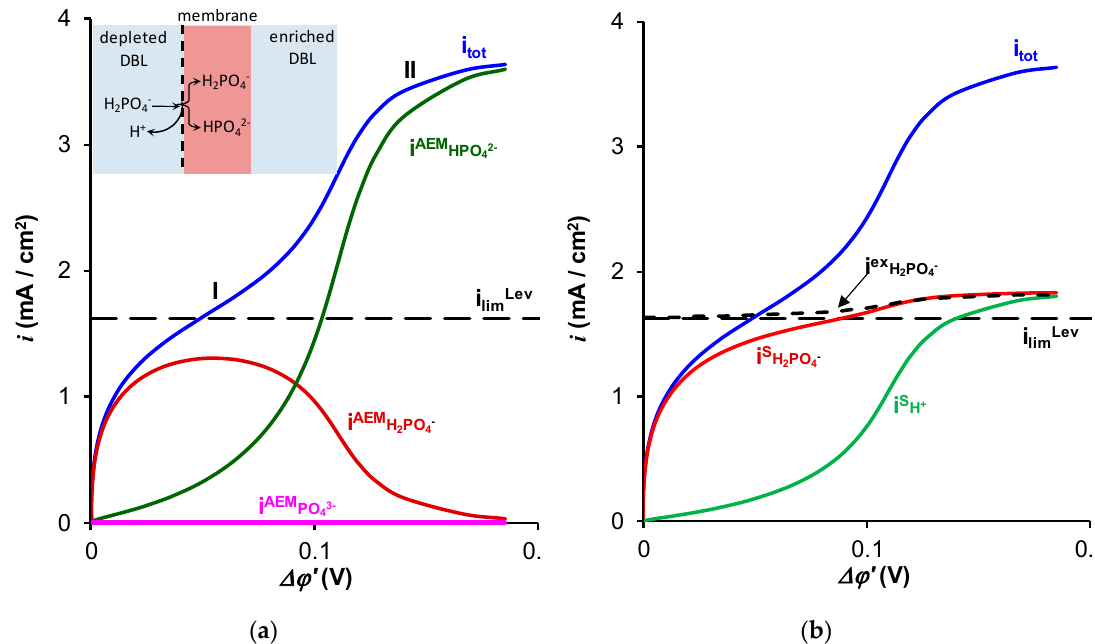
Figure 2. Theoretical total current density (i tot ) and partial currents of H 2 PO 4– ( i AEM ) ions in an AMX membrane ( a ) as well as the partial currents of H 2 PO 4– ( i s HPO 42 − ( i s ) ions in the depleted solution at the membrane surface ( b ) as functions of the corrected potential H + drop. Solid lines were calculated using the model [31,32]. Dashed lines show the limiting current i Lev calculated using the Leveque equation, Equation (6), and the exaltation current, i ex using Equation (1). “I” and “II” show the first and second inclined plateaus, respectively.